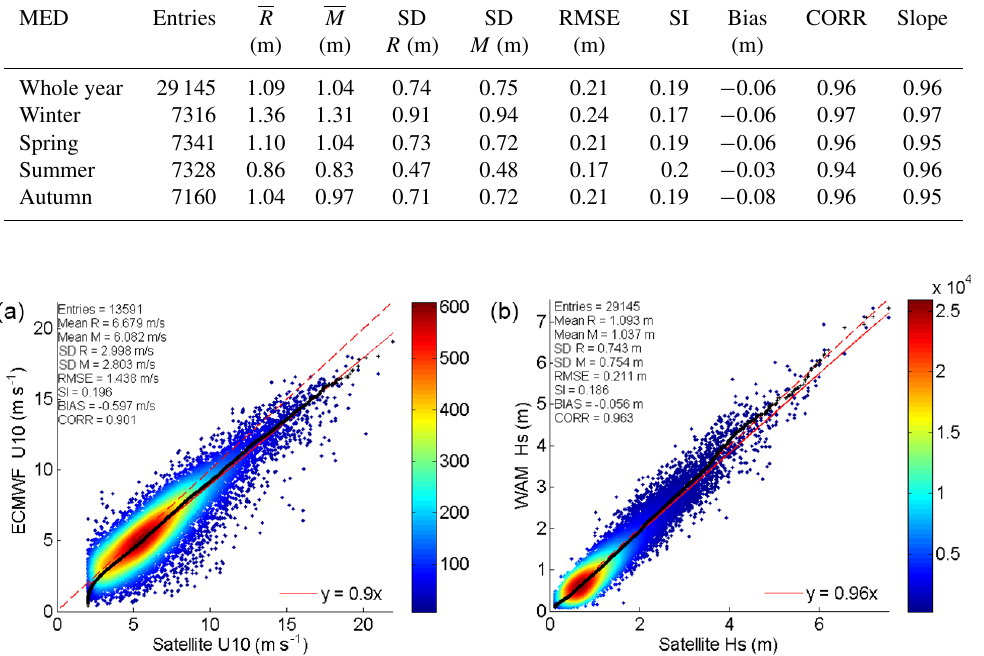
full Mediterranean Sea, for a 1-year period and